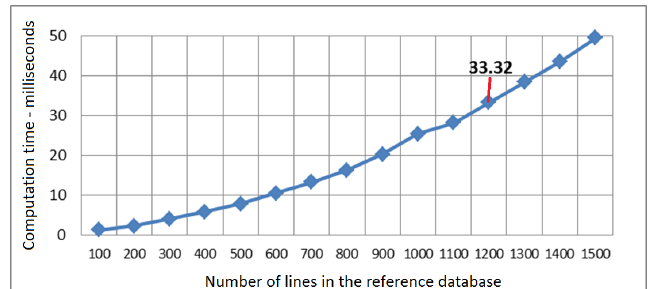
Fig. 9. Module recognition computation times according to database number of lines